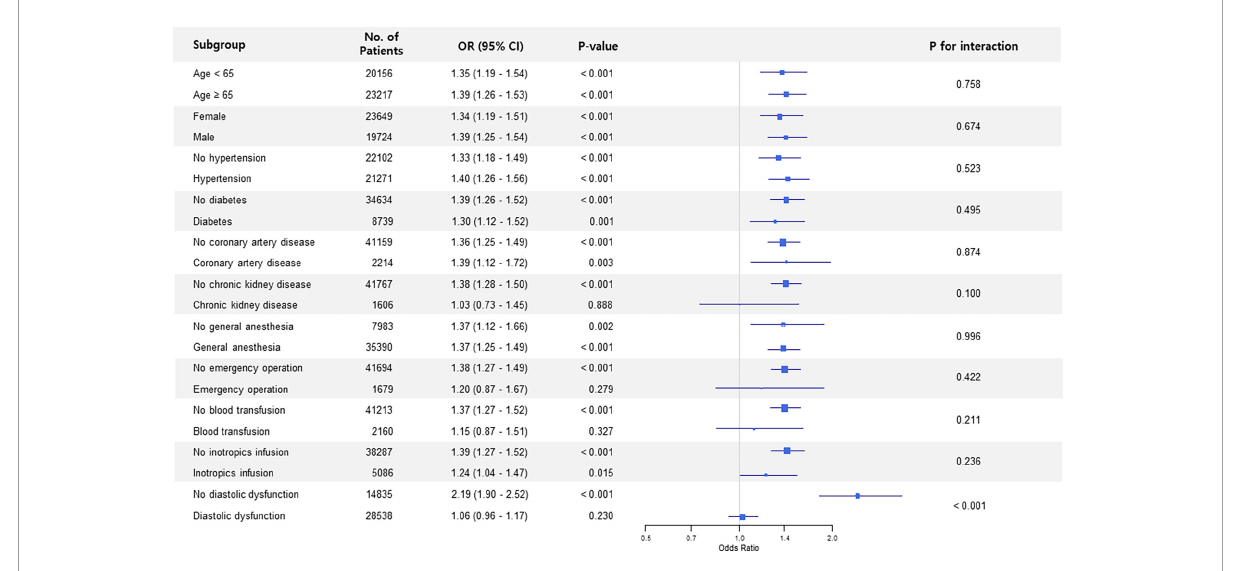
FIGURE1 Forest plot of subgroup analysis in non-thoracic